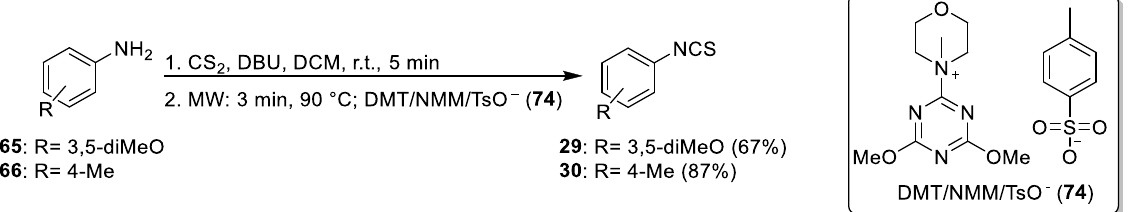
Scheme 3. Method C: synthesis of isothiocyanate derivatives of methyl ester amino acids 7 – 9 using DMT/NMM/TsO − ( 74 ) as desulfurating reagent.